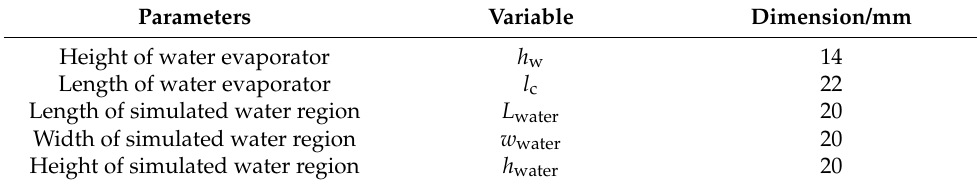
Table 1. Structure parameters of water evaporator.